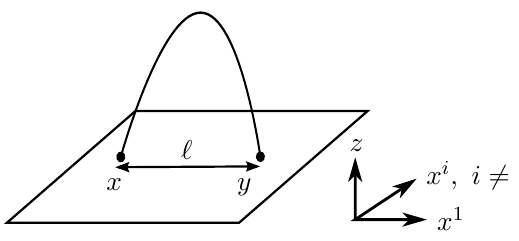
Figure 16. Width and associated bulk